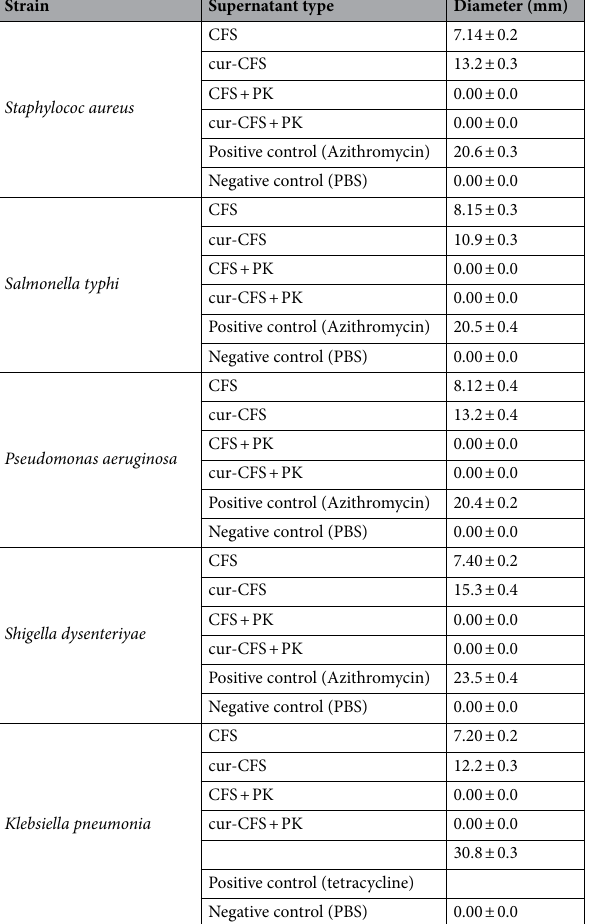
Table 2. Zone of inhibition diameter formed by CFS and cur-CFS against pathogenic bacteria Shigella dysenteriyae, Staphylococ aureus, Klebsiella pneumoniae, Salmonella typhi, and Pseudomonas aeruginosa